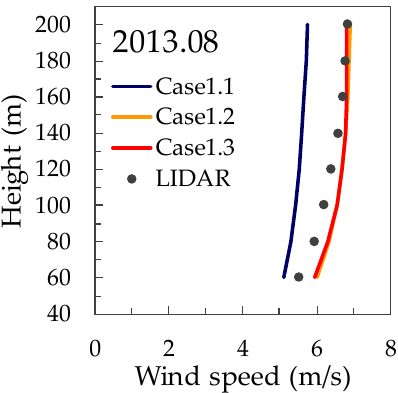
Figure 6. Effect of nudging height on the monthly average wind speed at the Choshi site.in August 2013.